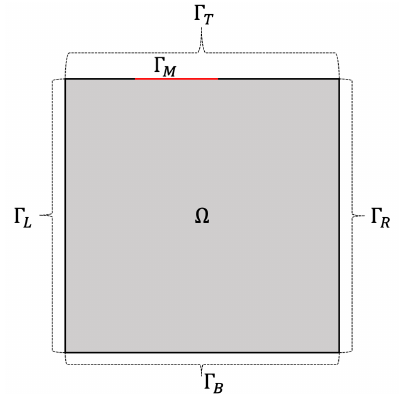
Figure 1. Illustration of the computational domain Ω with